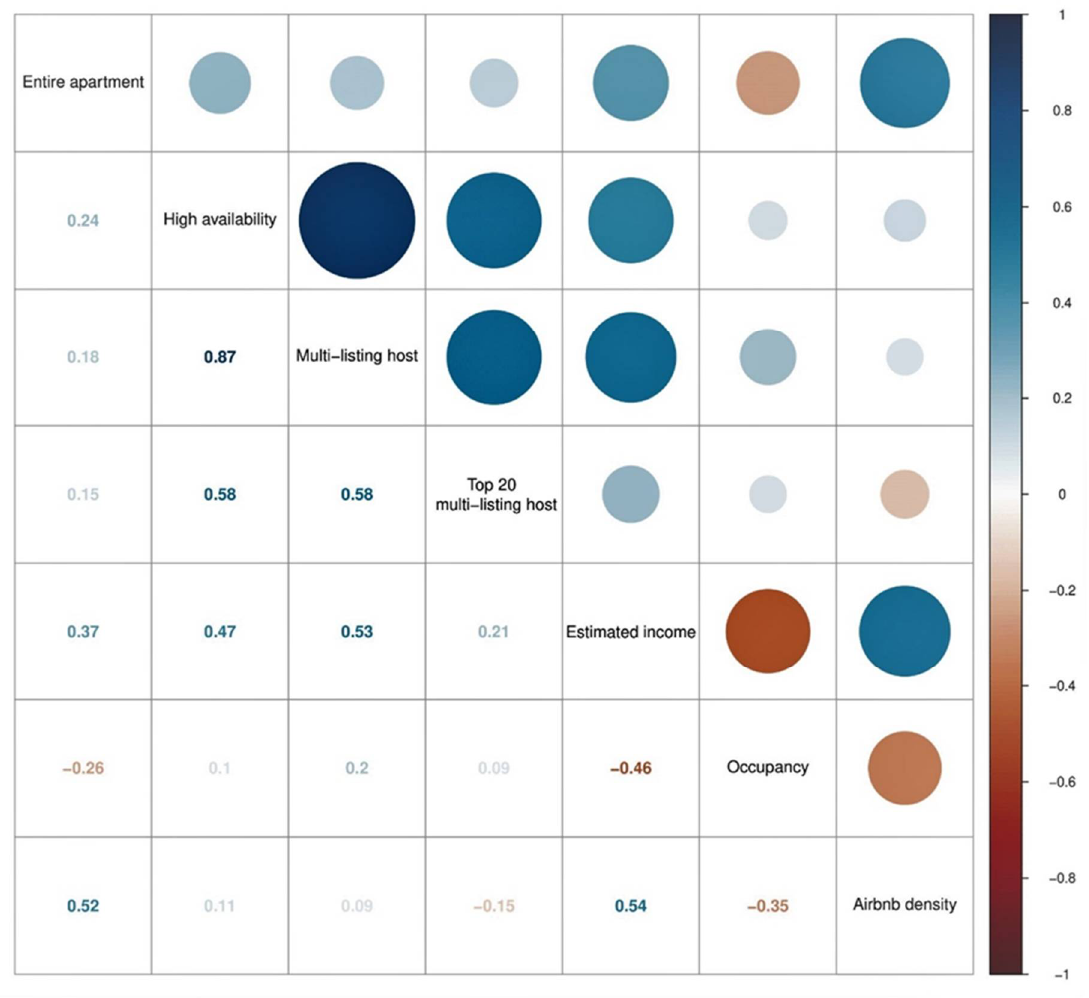
Figure 1. Results of Pearson correlation between variables. Source: author’s own elaboration.